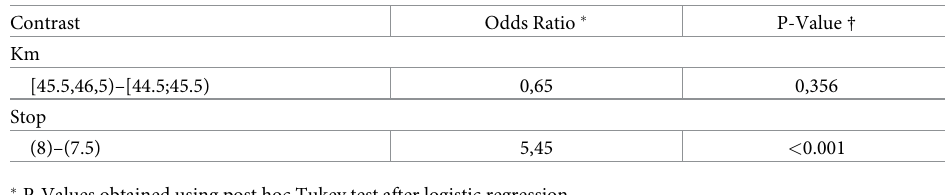
Table 3. Odds ratios of keratometry and free flap incidence.